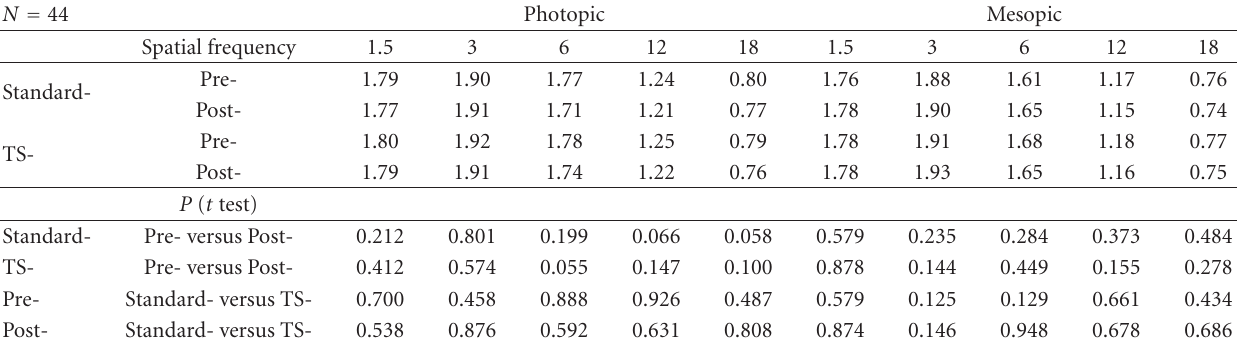
Table 3: Pre- and postoperative contrast sensitivity in Group 2 ( − 3D < sphere (cid:2) − 6D) underwent tissue-saving LASIK or standard LASIK. N =